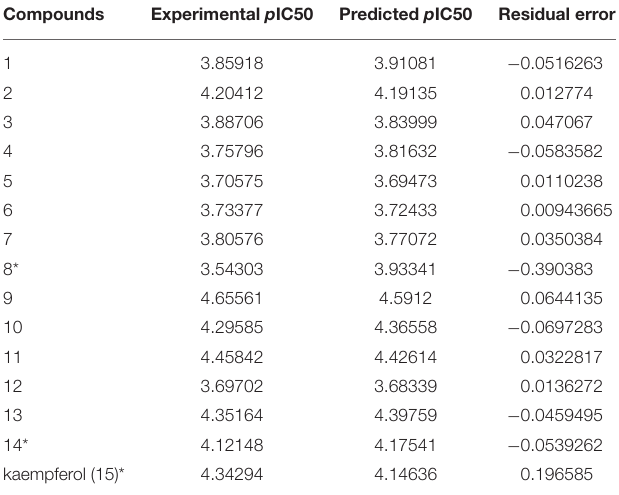
TABLE 3 | Experimental and predicted inhibitory activities of 15 compounds by 3D-QSAR model against HepG2. Compounds